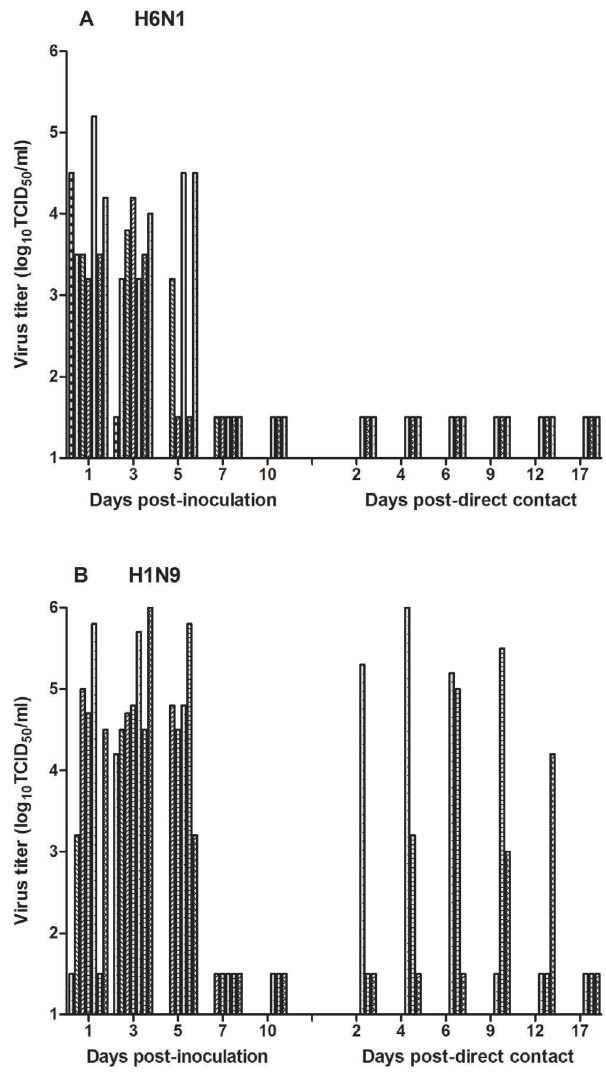
Figure 1. Nasal shedding and direct contact transmission of wild bird influenza viruses in ferrets. Seven ferrets were intranasally inoculated with 5 6 10 5 PFUs of either H6N1 (A) or H1N9 (B) and nasal washes were collected and titered on MDCK cells (days post-inoculation portion of graph). Three naı¨ve ferrets were paired with three of the inoculated ferrets 24 hours post inoculation for each virus group (days post-direct contact portion); nasal washes were collected titered on MDCK cells. Both H6N1 and H1N9 demonstrated replication in the upper respiratory tract of the ferrets, however, viral shedding was consistently greater in magnitude and duration for H1N9. H1N9 demonstrated direct contact transmission, but H6N1 did not transmit to direct contact